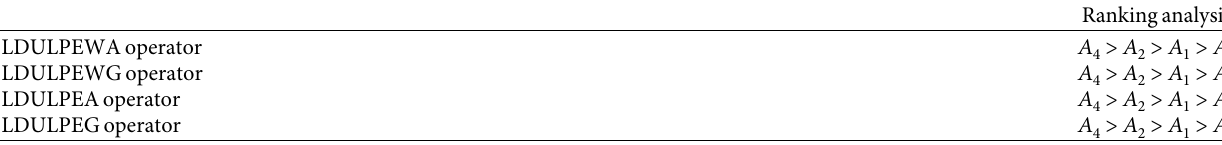
Ranking analysis